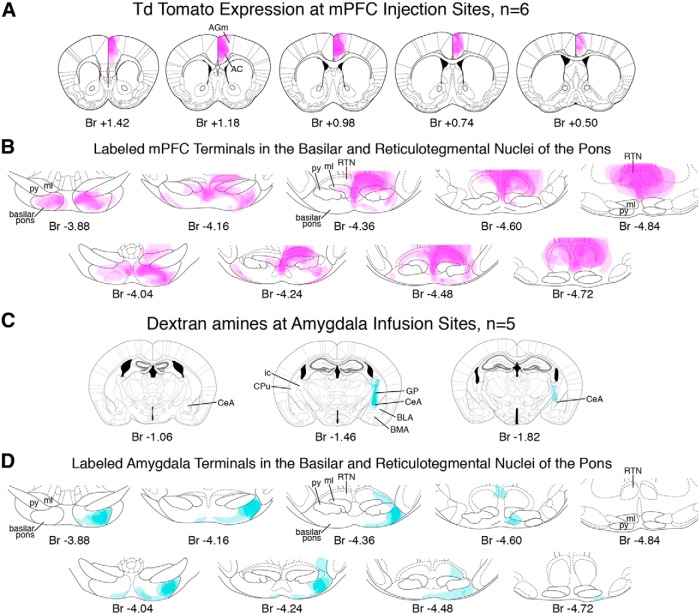
Summaries of mPFC (magenta) and amygdala (cyan) terminal distribution in the basilar pons and RTN. A. Reconstructions of td Tomato expressing mPFC cells (n = 6 mice, opacity for each mouse adjusted such that overlap of all mice = 100%). Note that the greatest overlap in expression was largely restricted to mPFC regions that are necessary for acquisition of trace eyeblink conditioning (compare with Fig. 6C
). B, Reconstructions of mPFC terminal labeling in the basilar pons and RTN (opacity for each mouse adjusted such that overlap of all mice = 100%). The greatest overlap was observed in the anterior basilar pons (left sections), and throughout the RTN and surrounding brain regions (right sections). C, Reconstructions of AlexaFluor-conjugated dextran infusions targeting the amygdala central nucleus (n = 5 mice, opacity adjusted such that all mice = 100%). The highest concentrations of dextran deposit overlapped with the central nucleus in all cases. D, Reconstructions of central amygdala terminal labeling in the basilar pons (opacity adjusted such that all mice = 100%). The greatest overlap across animals was observed in the anterior basilar pons (left sections), whereas few terminals were observed in the RTN (right sections).